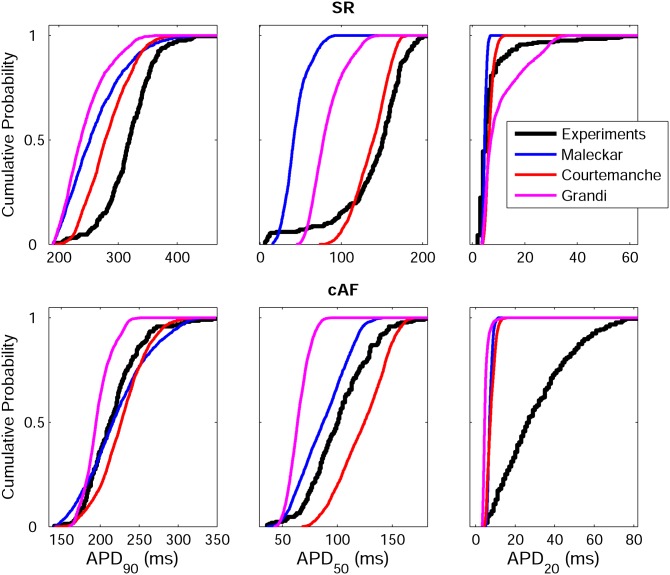
Empirical cumulative distribution curves for APD90, APD50 and APD20.Curves for experimental data (black) and the populations of models based on the Maleckar (blue), Courtemanche (red) and Grandi (magenta) models in both SR (top panels) and cAF (bottom panels).